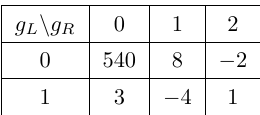
for the homology class β = ( d β